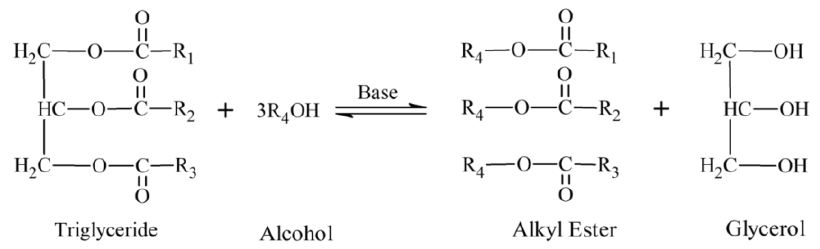
Figure 1. Three consecutive reversible reactions of the transesterification reaction.